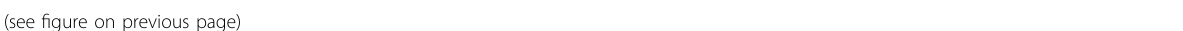
mediated by STX17 depletion (Supplementary Fig. S5B).